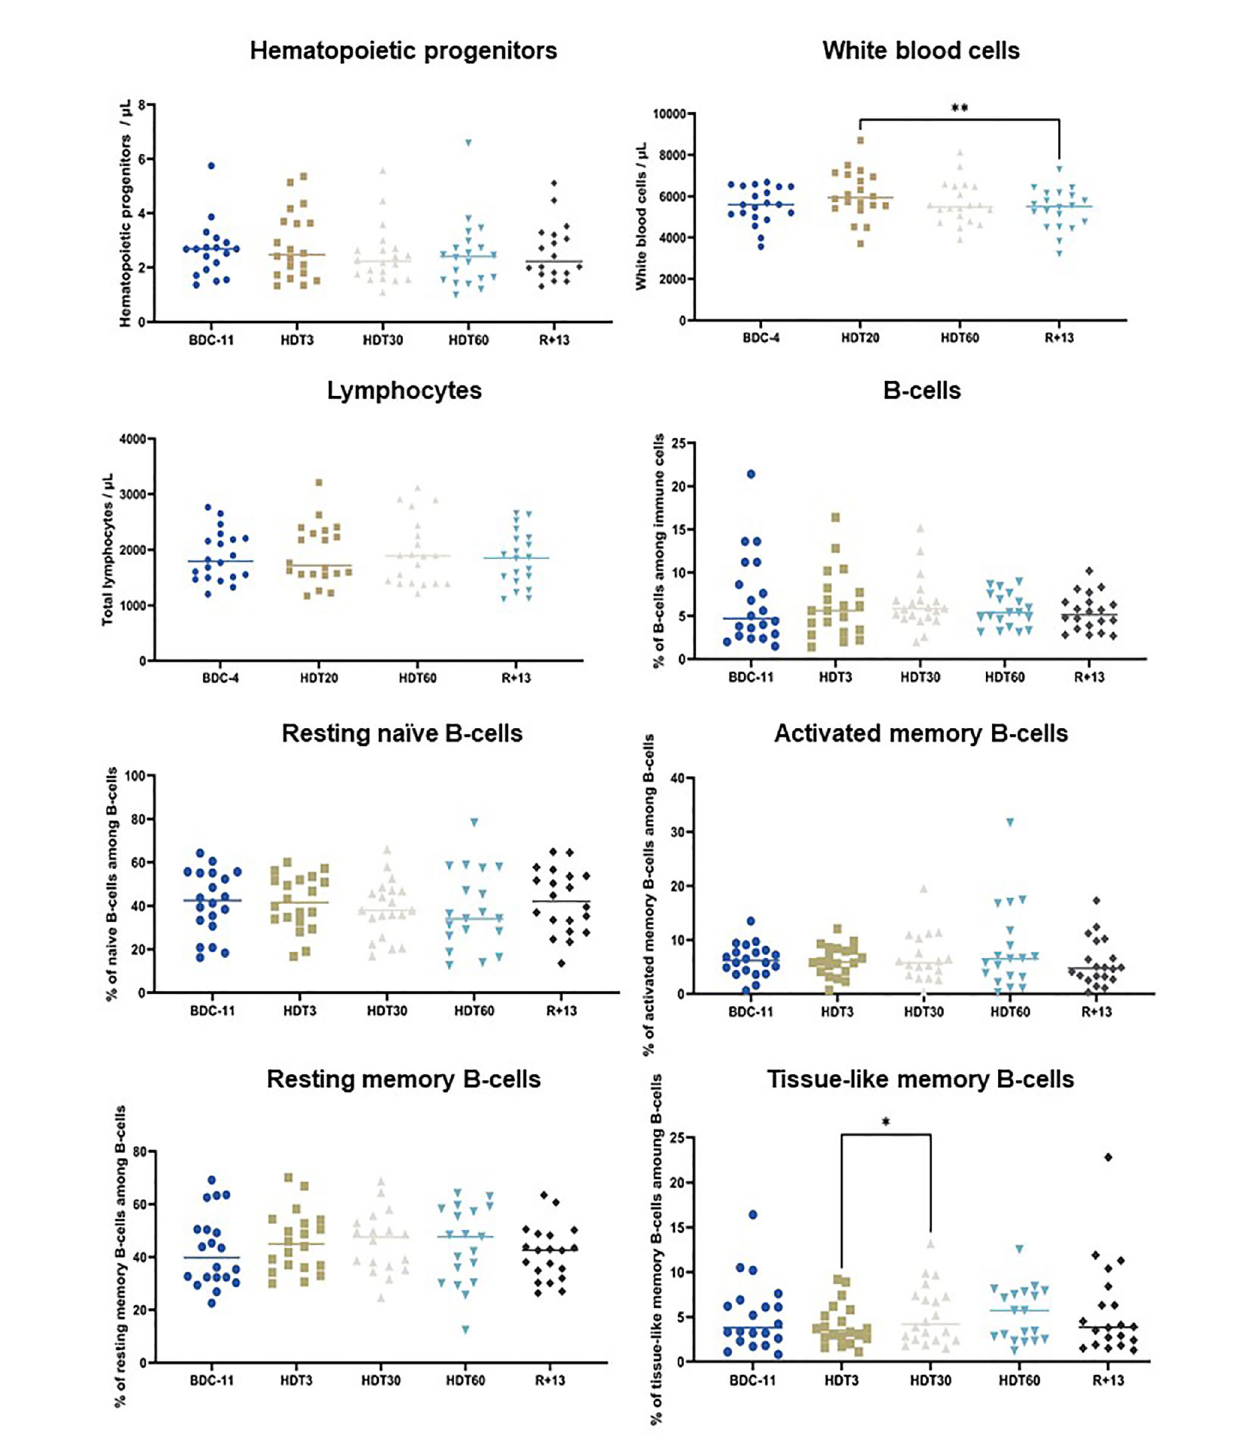
FIGURE 3 | Effects of bed rest on hematopoietic progenitors, white blood cells, circulating lymphocytes, total B-cells, resting naïve B-cells, resting memory B-cells, activated memory B-cells and tissue-like memory B-cells. As no statistically signi fi cant differences between the control and cocktail groups were observed, individuals of both groups were pooled. n = 18-20. Horizontal bars indicate the median. Statistically signi fi cant differences were found using either one-way ANOVA or a linear mixed effects model analysis. *p < 0.05; **p < 0.01. BDC, baseline data collection; HDT, head-down tilt bed rest; R,